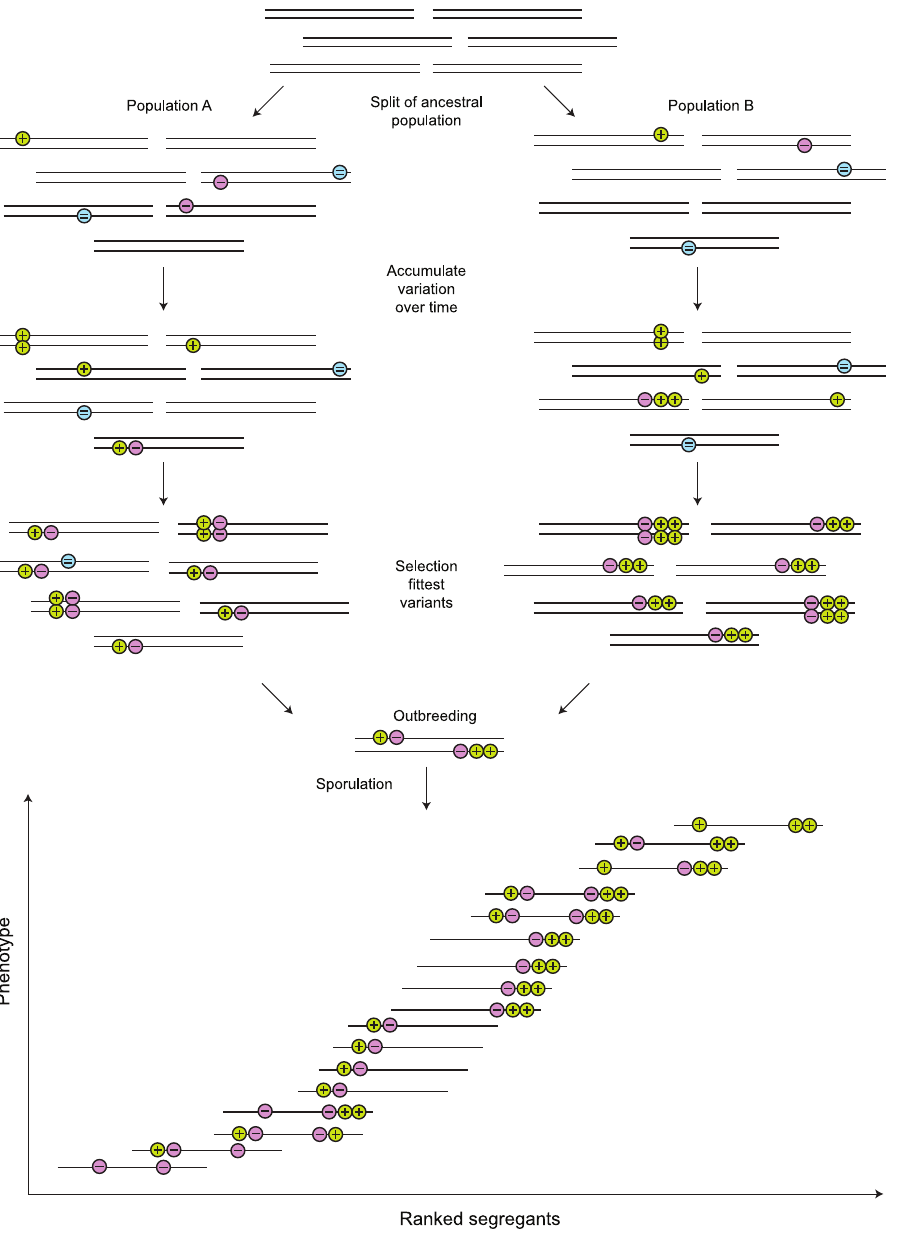
Figure 3. Linked quantitative trait loci (QTLs) can arise through normal population genetic processes. For any given phenotype there are many loci where mutations can have an effect. Different populations will experience mutations in different loci affecting the same phenotype. These mutations can affect a phenotype in a positive ( + ) or negative ( 2 ) way and if nearly neutral (=) will remain segregating within a population for awhile. As other mutations occur, advantageous combinations can result with better fitness than either mutation alone or the original parental alleles. Multiple mutations with effects upon a trait will be broken up by recombination if not linked and one or more can therefore be lost. Linked mutations can become fixed as blocks of larger collections of QTLs if the combination of alleles is beneficial. Different populations may evolve different ‘‘super’’-QTLs, which are revealed when the populations interbreed. Offspring will express a range of phenotypes depending on which QTLs are inherited and how much recombination breaks up the linked groups. Multiple rounds of interbreeding can further break up the linked QTLs revealing individual loci, as illustrated in Figure 2.